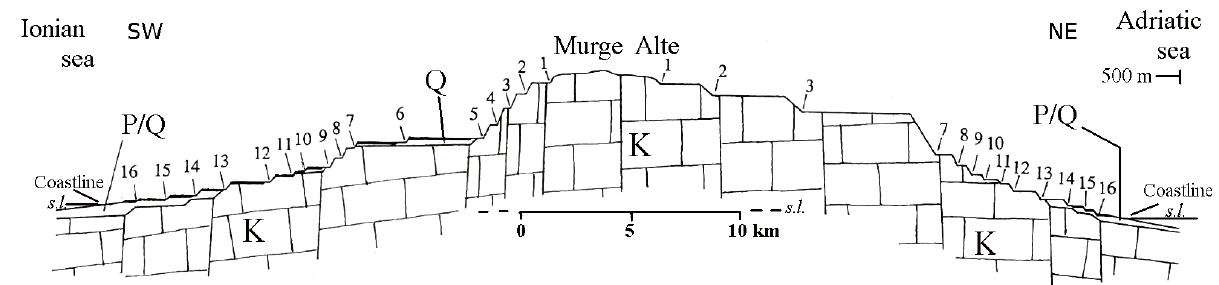
Figure 3. A cross-section of the Apulia foreland near the study area highlights the stepped structure of the Murgia plateau. Location in Figure 1. Legend: (1–16): uplifted shorelines (middle–late Pleistocene), P-Q: Bradanic trough cycle (late Pliocene–early Pleistocene), K: Apulia foreland carbonates (Cretaceous). Modified from [30].